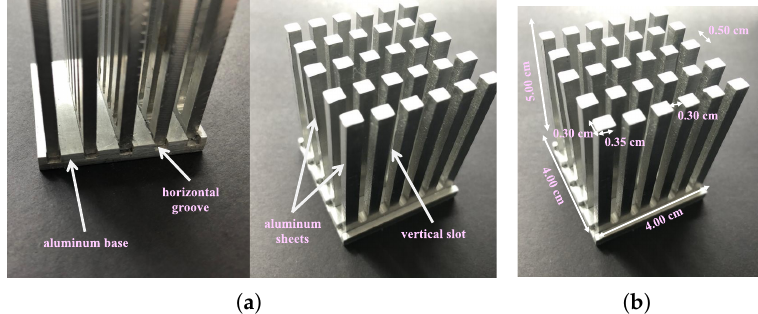
Figure 4. Water condenser element. ( a ) Parts. ( b ) Dimensions.